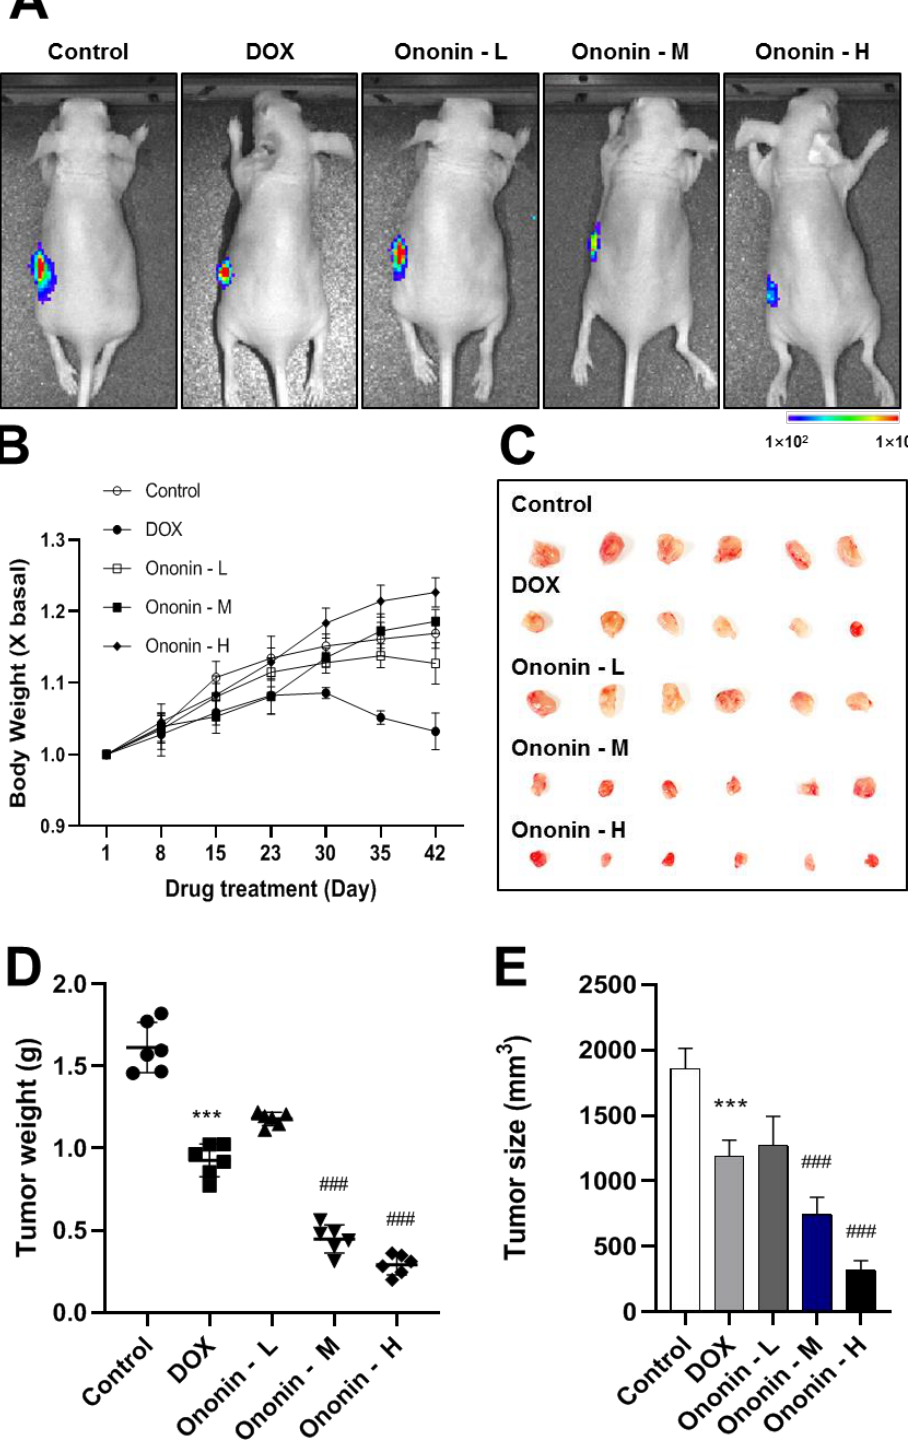
Figure 6. ( A ) Representative bioluminescence imaging of nude mice xenograft tumor after 42 days of treatment. The control group received PBS; the DOX group received DOX (2 mg/kg/i.p); the ononin group received different amounts of ononin (1, 3, and 10 mg/kg/i.p). ( B ) The mice’s body weight was recorded during the 42-day investigation. ( C ) On day 42, tumors were removed from mice. ( D ) After the studies, the tumor weight was calculated. ( E ) On day 42, the tumor size was calculated. The data were reported as Mean SEM, with n = 6. *** p < 0.001 was considered a significant result as compared to the control group; ### p < 0.001 was considered a significant result as compared to the DOX group.